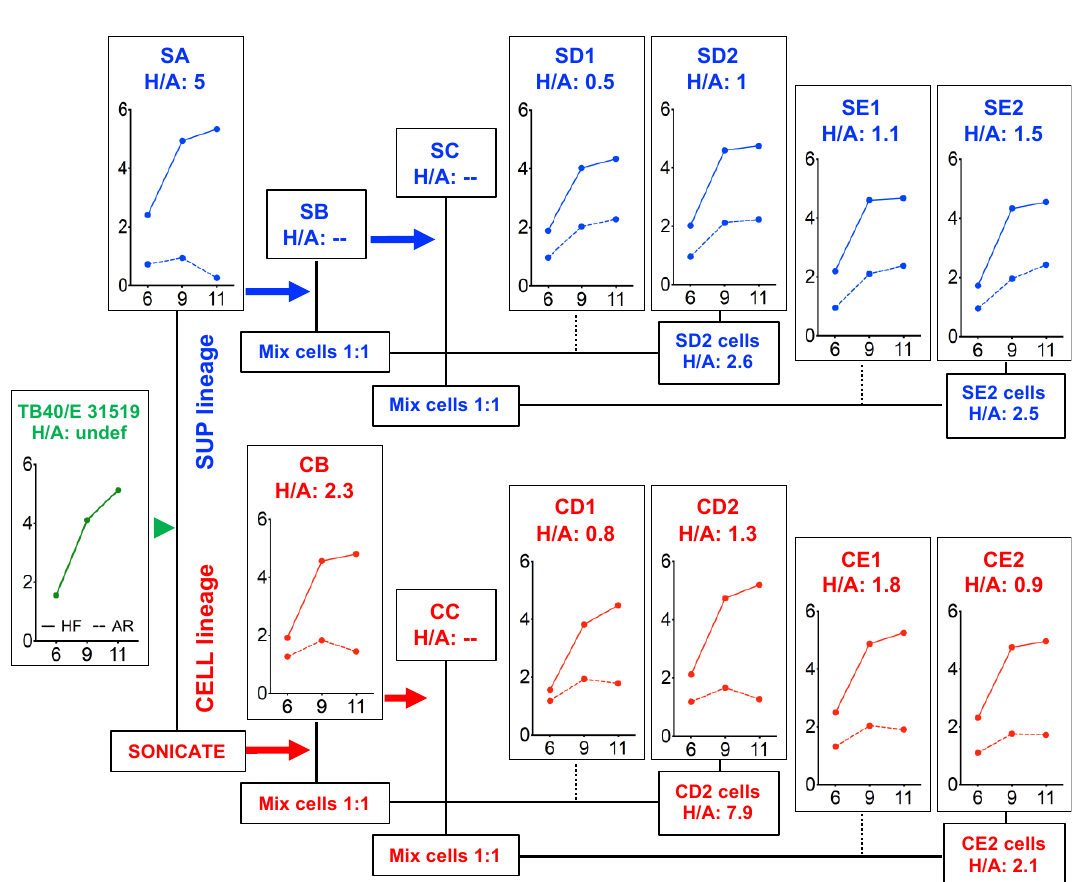
Figure 3. Growth properties of the parental TB40/E stock virus and of derived adapted populations. The adaptation scheme shown is the same as depicted in Figure S1. The % IE+ HFF / % IE+ ARPE-19 cell ratios (H/A) at day 1 post-infection of HFF and ARPE-19 cells infected with each stock at an MOI of 0.01 pfu/cell and the virus content of supernatants collected at days 6, 9 and 11 pi (X axis) as determined by titration on HFF (Log 10 pfu/well, Y axis) are shown. Solid lines = virus yields from infected HFF. Dotted lines = virus yields from infected ARPE-19 cells. Green font = initial TB40/E 31519 stock. Blue font = “supernatant lineage” stocks. Red font = “cell lineage” stocks. Undef = as no IE+ cells were observed in ARPE-19 cells, the denominator of the H/A ratio is zero. No IE+ nuclei, and no progeny release were observed upon infection of ARPE-19 cells with the 31915 stock, while robust growth was detected on HFF (Figure 3, TB40/E panel). As expected, the